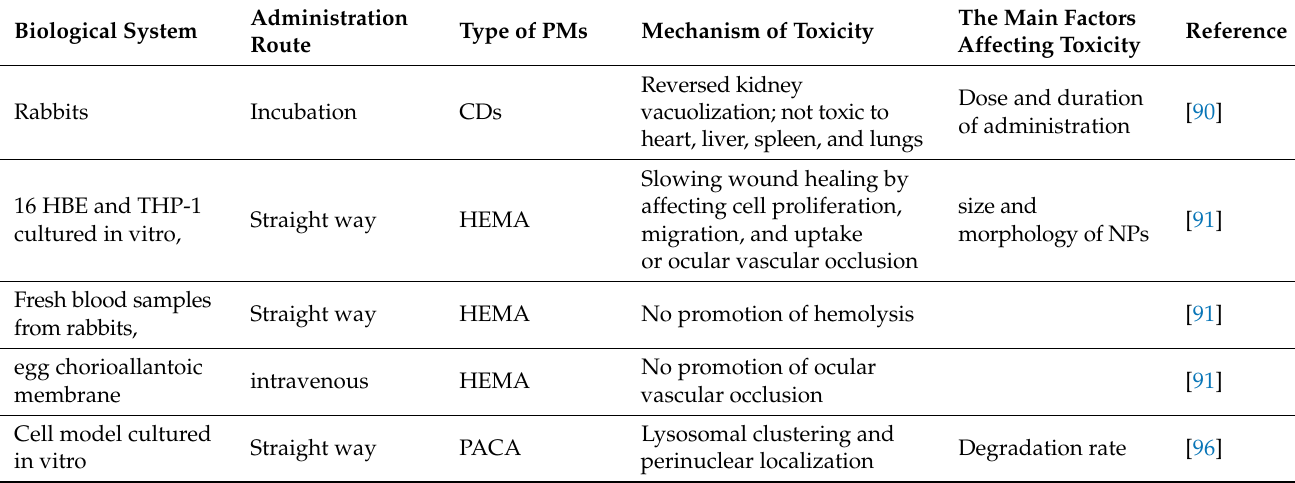
Table 2. Experimental studies on toxicity of polymeric